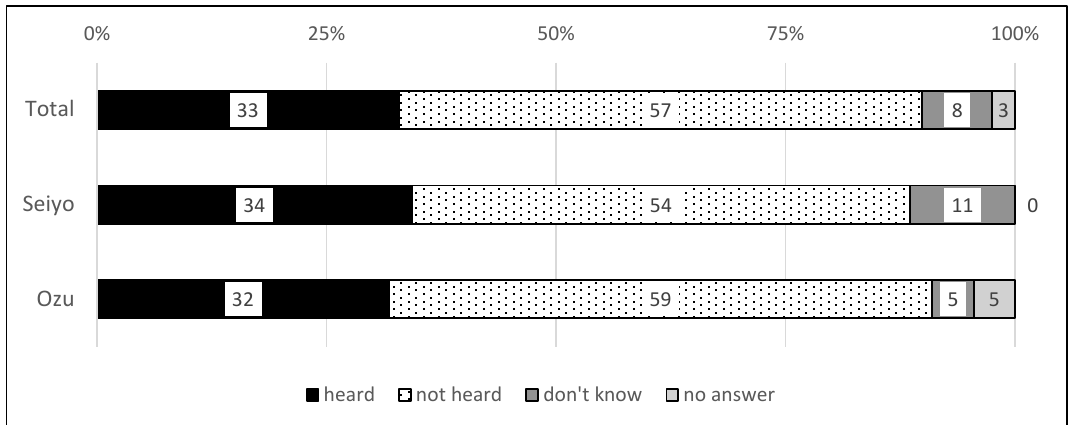
8 of 20 Table 4. Overview of the questionnaire survey . Target of Survey